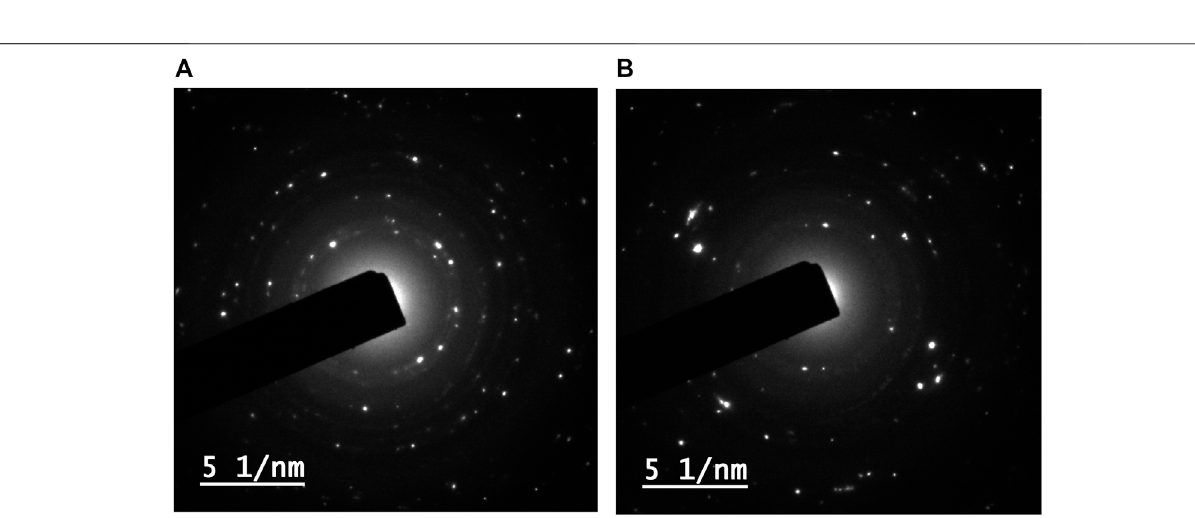
Frontiers in Bioengineering and Biotechnology |